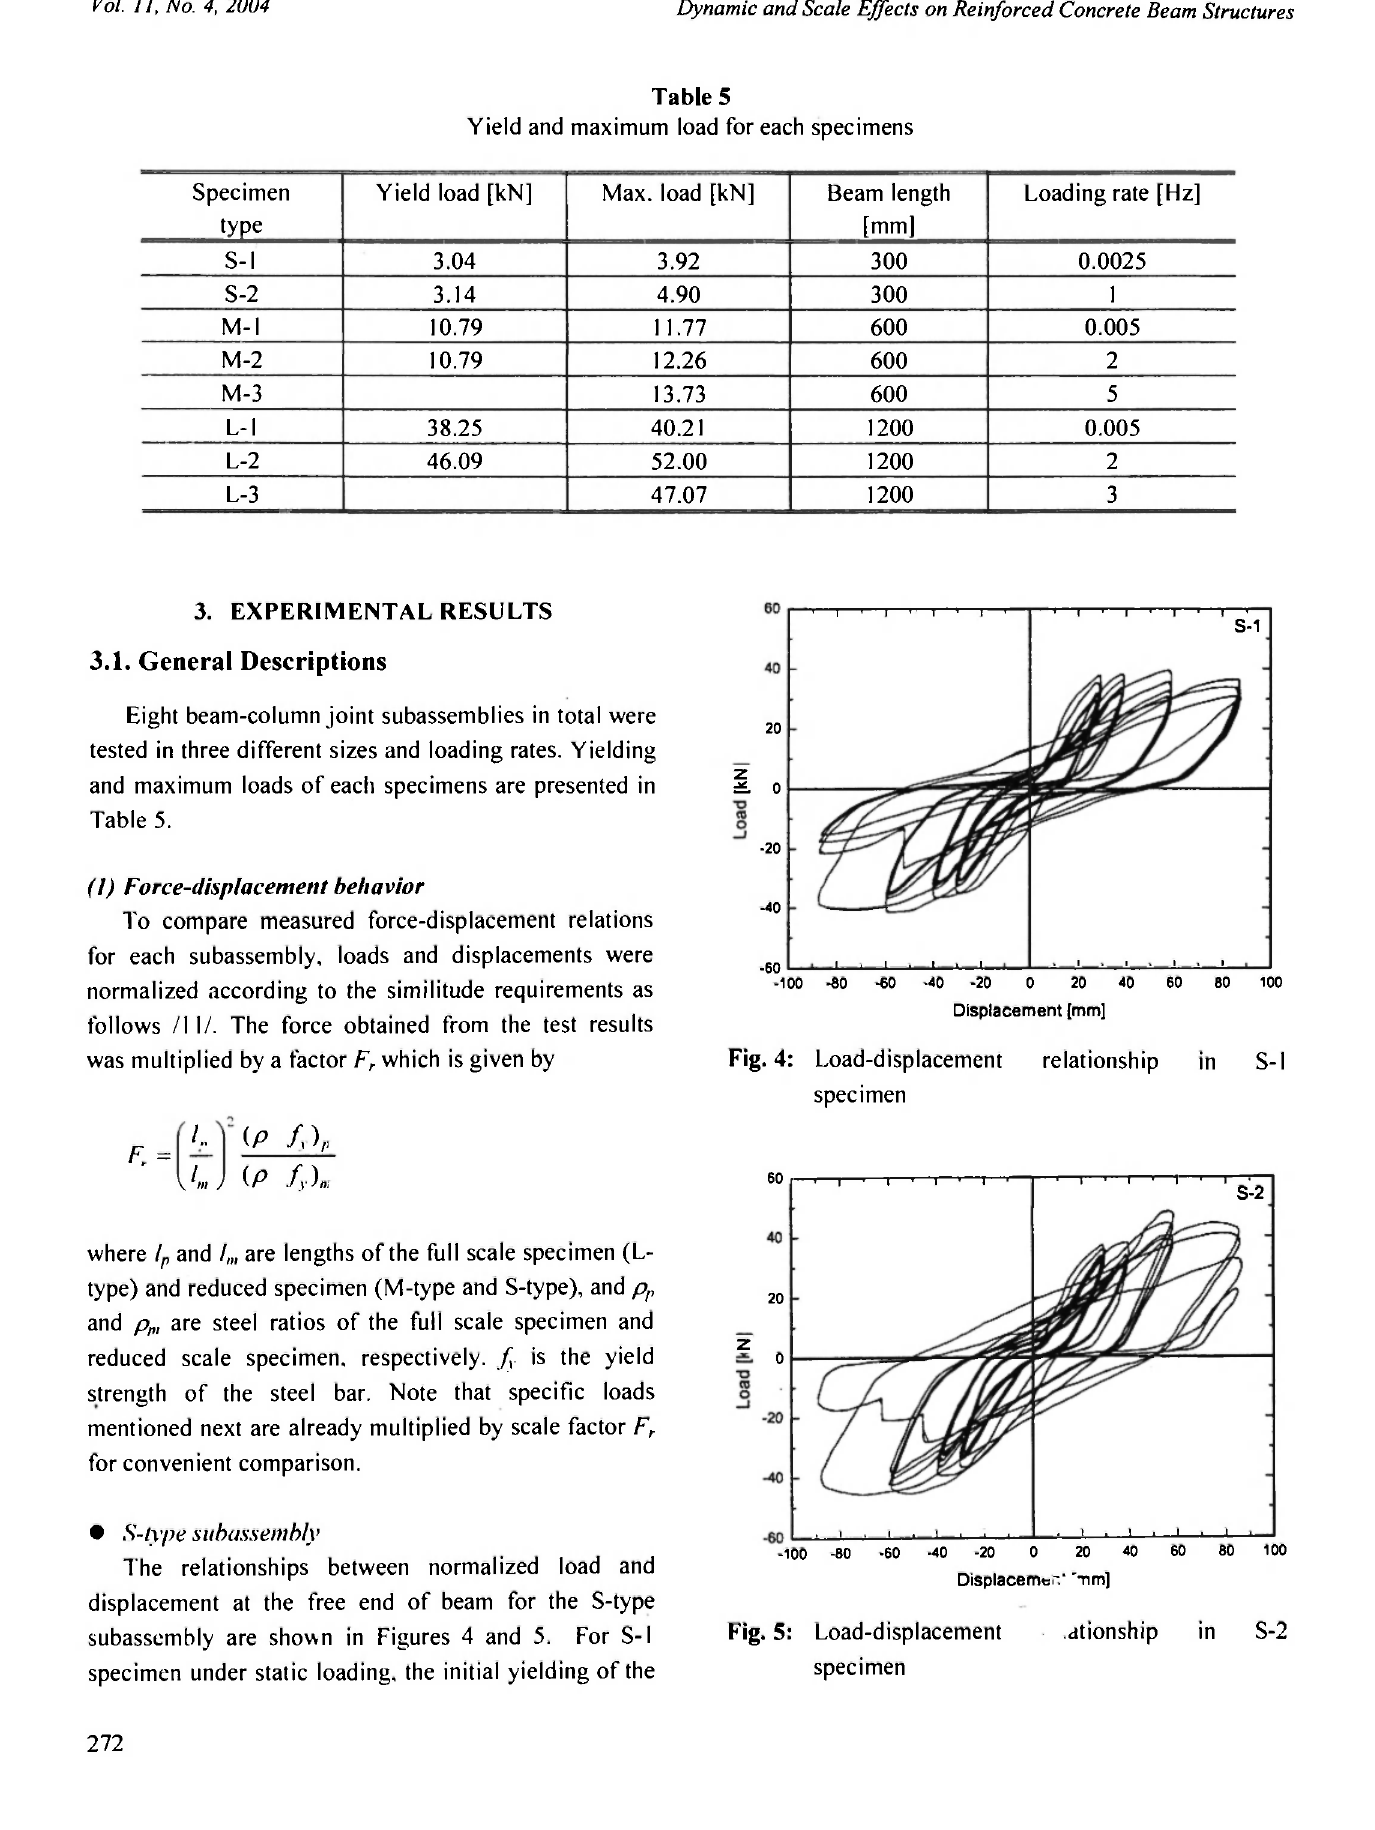
Fig. 5: Load-displacement ationship in S-2